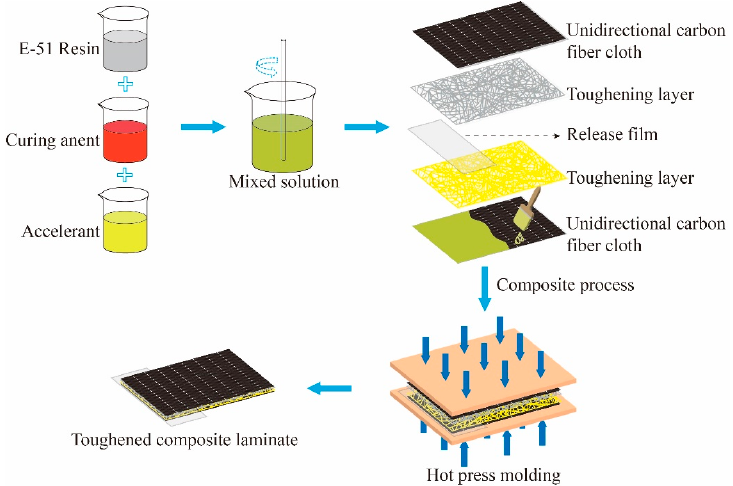
Figure 9. Schematic view of manufacturing toughened composite laminates.